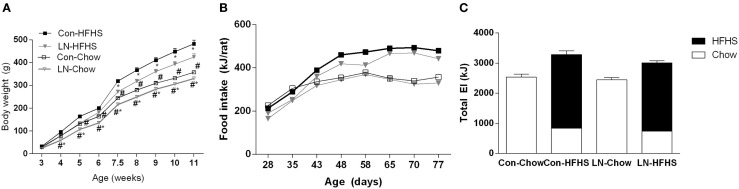
Body weight trajectory of male pups from weaning to 11 weeks of age for chow (Con-Chow and LN-Chow) and HFHS (Con-HFHS and LN-HFHS) fed groups (A). Weekly energy intake (kJ/rat) for Con-Chow, LN-Chow, Con-HFHS and LN-HFHS, n = 3–4 cages/group (B). Total weekly energy intake for entire experimental window (C), with energy from chow shown in open and HFHS diet in closed bars. Results are expressed as mean ± SEM, n = 11–15/group; data were analyzed by repeated measures one-way ANOVA (A,B) and two-way ANOVA (C) followed by LSD. Definitions: Con-HFHS [control-HFHS; Con: normal bedding with mother; HFHS: post-weaning, postnatal day (PND) 21, chow, water, + HFHS] and LN-HFHS (LN-HFHS: LN: limited nesting material PND 2–9). #p < 0.05 versus rats consuming HFHS (diet effect). *p < 0.05 versus control rats consuming the same diet (LN effect).